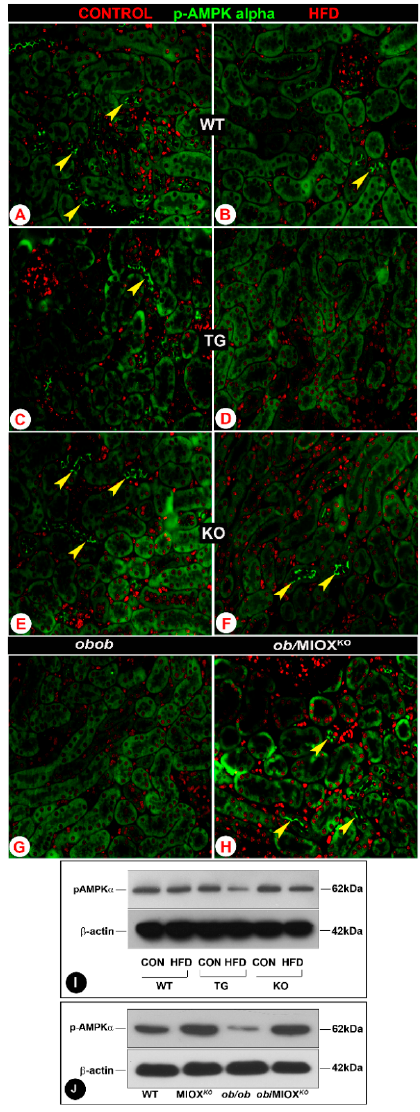
Figure 2. MIOX overexpression alters the expression of the metabolic sensor p-AMPK α in renal proximal tubules in a state of obesity. Panels ( A – H ): by immunofluorescence microscopy, a decrease in the expression p-AMPK α in the proximal tubular epithelia (arrowheads) was observed in WT, MIOX-TG and MIOX-KO mice following HFD administration. The lowest expression was observed in MIOX-TG mice, and MIOX-KO mice had discernible expression comparable to WT mice. The ob / ob mice had no expression of p-AMPK α , while it became detectable in some of the renal tubular epithelia in ob / MIOX KO mice (magnification 200 × ). Panels ( I , J ): Western blot data revealed changes in the expression of p-AMPK α that were parallel to those observed by immunofluorescence microscopy in various strains of mice in a state of